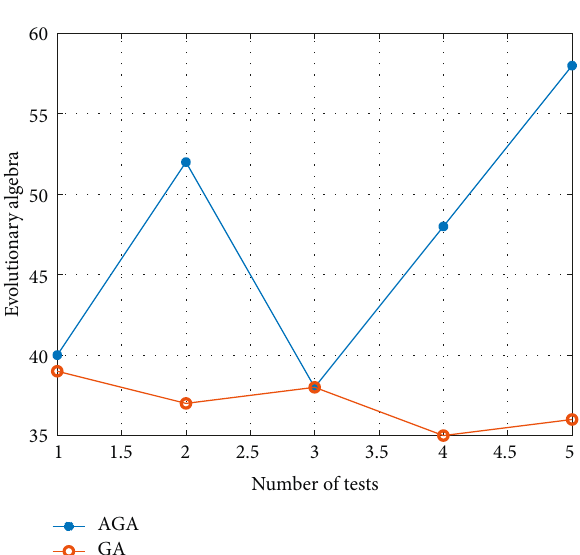
Figure 2: Comparison of the evolutionary algebra of algorithms.